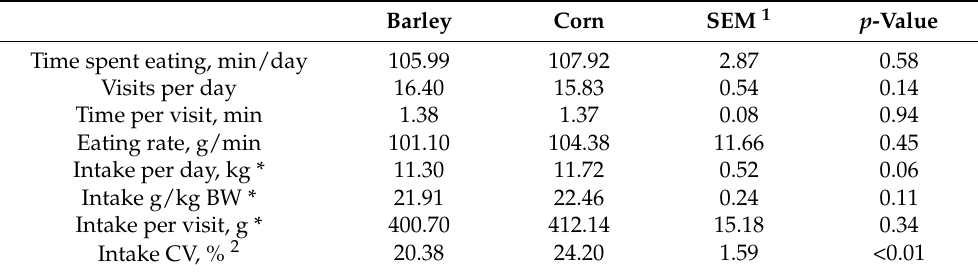
Table 3. Feeding behavior of steers consuming finishing diets containing corn or Hockett barley as basal grains at the Northern Agricultural Research Center. Barley Corn SEM 1 p -Value